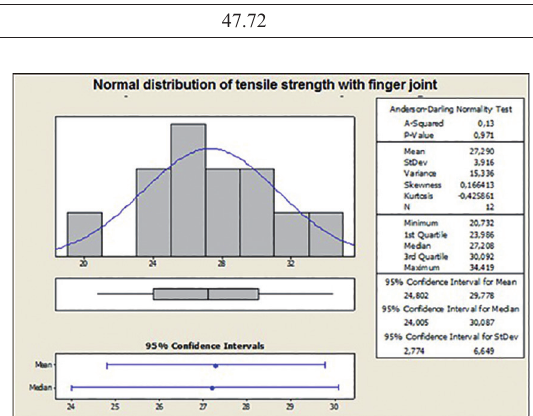
Table 5: Comparison between characteristic tensile test values. Characteristic value with finger joint (MPa) Characteristic value without finger joint (MPa)